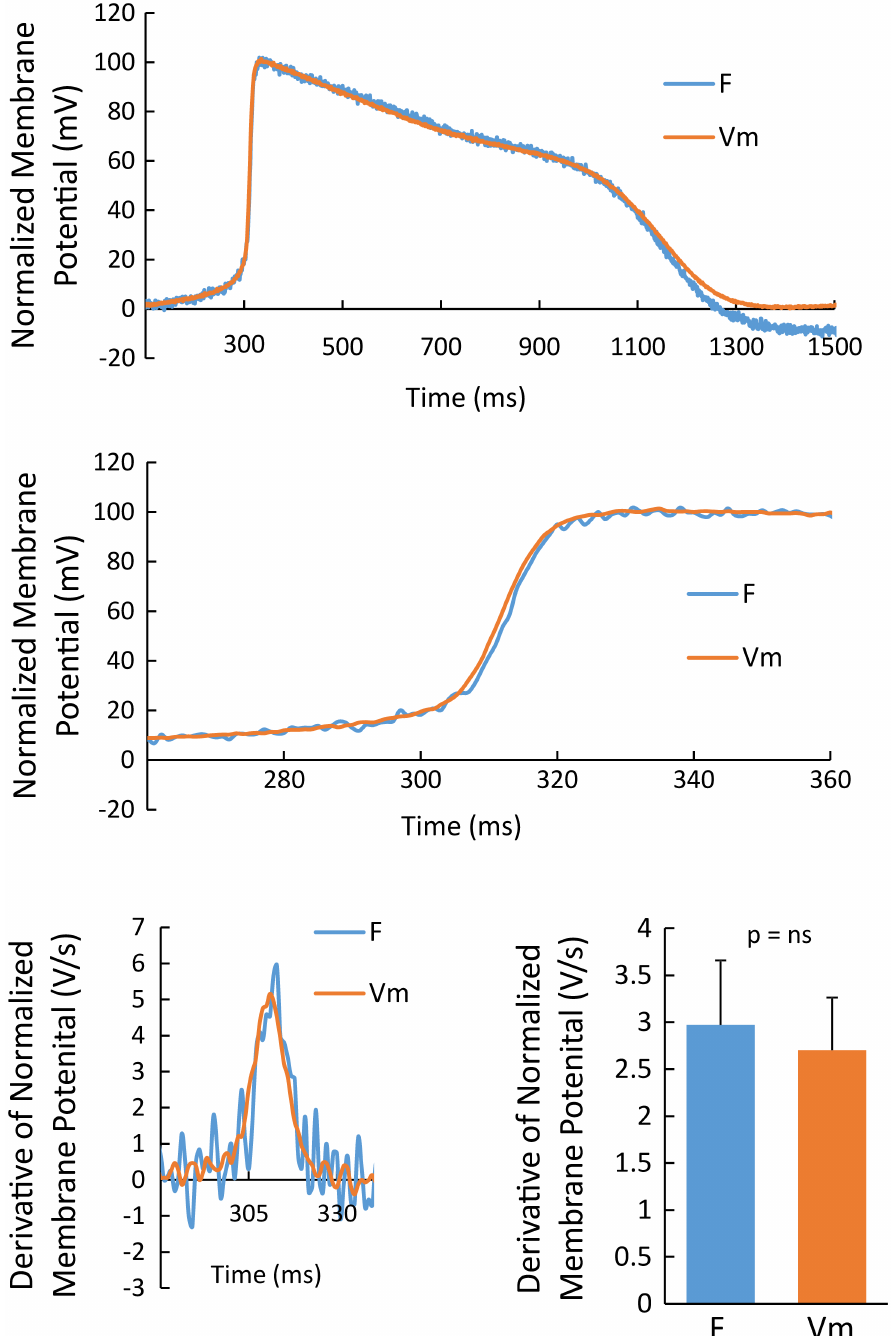
Fig 4. Comparison between electrical and optical measurements of action potentials. Comparisonof action potentialmeasuredusing FluoVolt (cyan) and a sharp microelectrode (orange) simultaneously (top) and at a much higherresolution showingthe action potential upstroke (middle). All action potential recordings are normalized to a 100 mV amplitude. In both plots, action potentialsrecordedwith FluoVolt and a sharp microelectrode are highlycorrelated.The action potentialupstroke derivative(dVm/dt) for these examples (bottom left) and over all recordingswere identical.